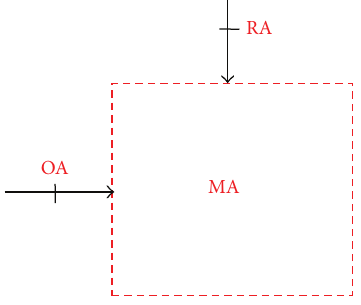
Figure 3: Schematic controlled volume of mixing process.